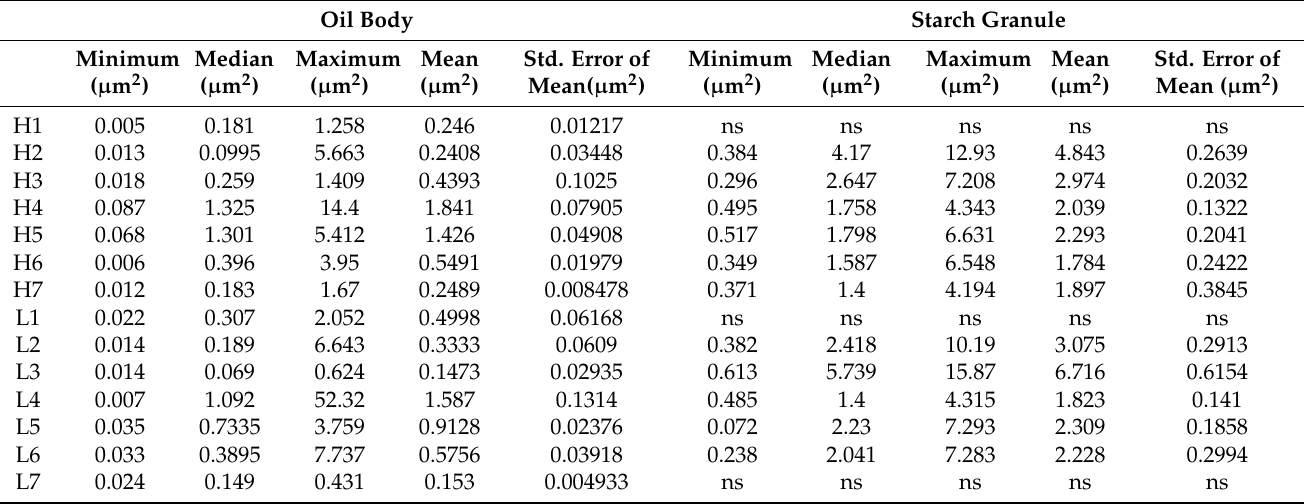
Table 1. Statistical value of oil body and starch granule size for HOC and LOC materials in 7 periods. Oil Body Starch